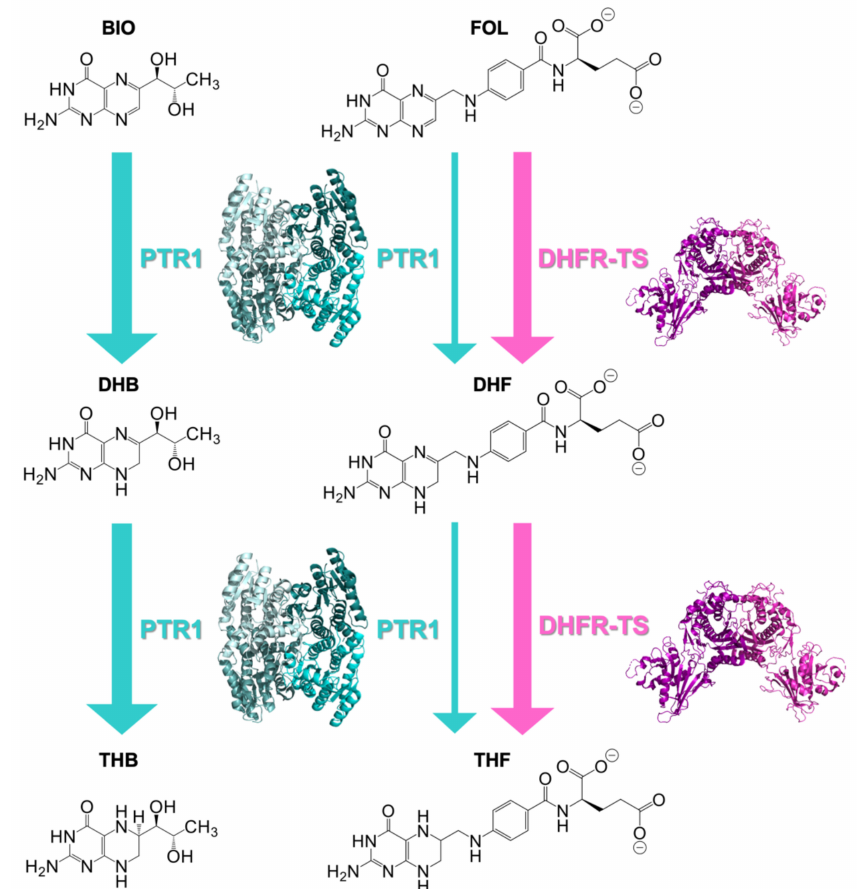
Figure 1. Two-stage reduction of biopterin (BIO) to 7,8-dihydrobiopterin (DHB) and 5,6,7,8- tetrahydrobiopterin (THB) catalyzed by PTR1 and of folate (FOL) to 7,8-dihydrofolate (DHF) and 5,6,7,8-tetrahydrofolate (THF) catalyzed by both dihydrofolate reductase-thymidylate synthase (DHFR-TS) and PTR1. Enzymes are shown next to the reactions that they catalyze. The thicker arrows indicate that the enzyme can contribute to the metabolic step only under specific metabolic conditions. Indeed, DHFR-TS is mainly responsible for the folate-reduction pathway, whereas PTR1 accounts for the biopterin one, being involved in the folate-reduction subsequently to DHFR inhibition.